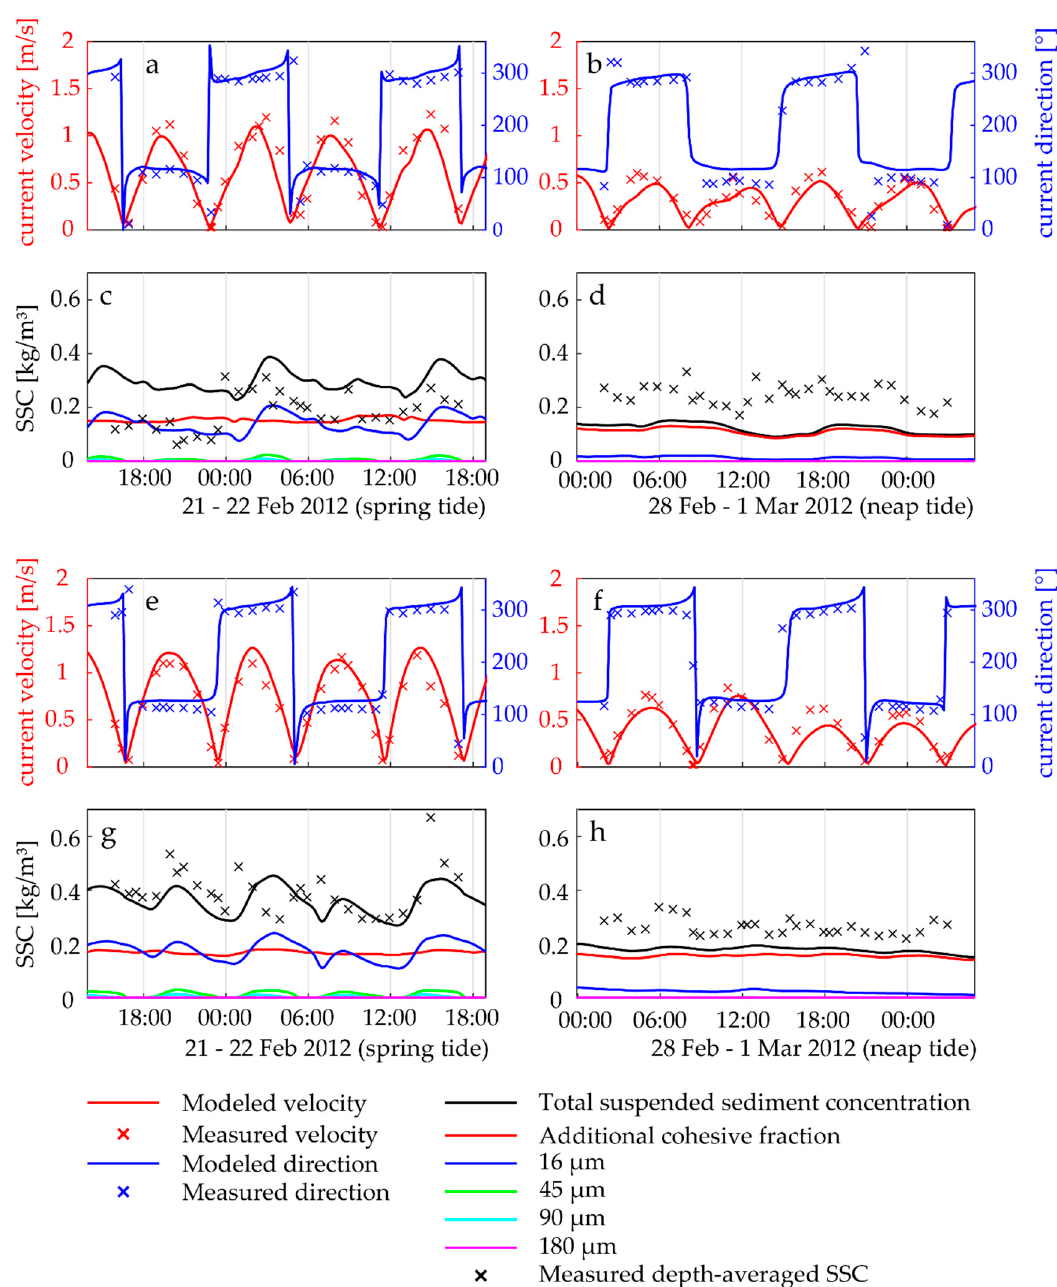
Figure 5. Calculated and measured current velocities, direction and suspended sediment concentration at monitoring stations N1 ( a – d ) and N7 ( e – h ), located at the upper Xiaomiaohong inlet and Sanshahong inlet, respectively. The left panels correspond to spring tidal conditions (21 February 2012 until 22 February 2012), the right panels correspond to neap tide conditions (28 February 2012 until 1 March 2012).